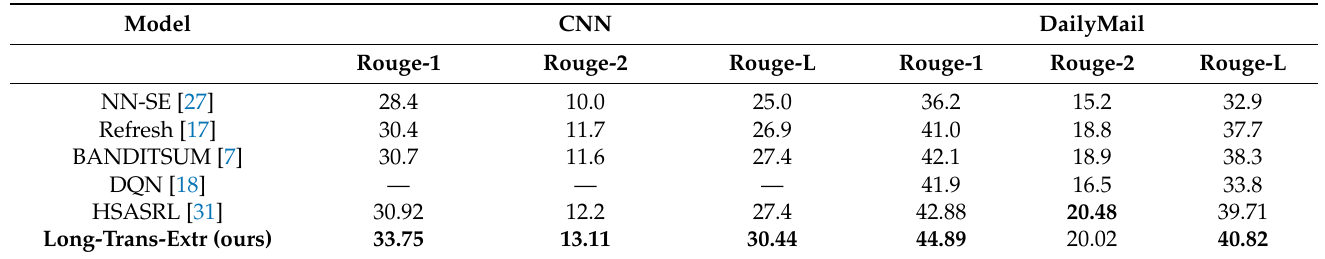
Table 4. The experimental results of Long-Trans-Extr and other methods on the CNN and DailyMail datasets, respectively.